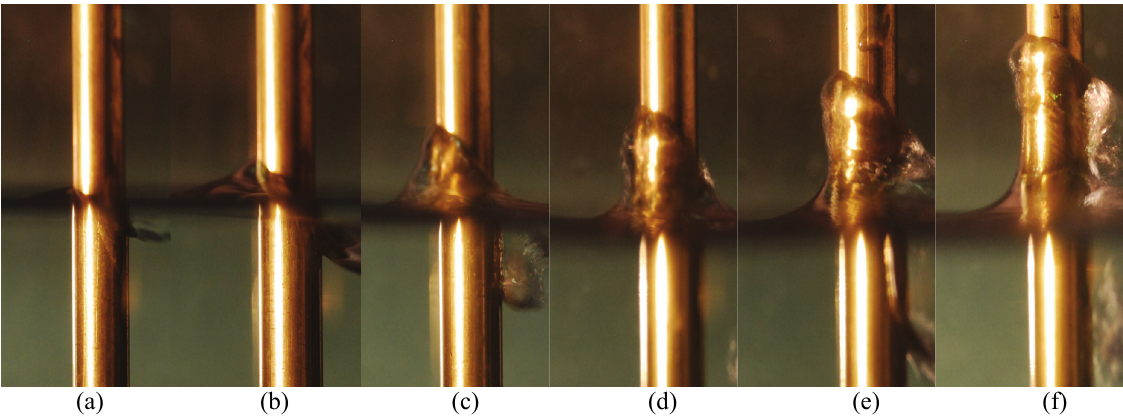
Fig. 4. The aspect of rising of the water surface, submerge depth is 50mm; (a) 0.33m/s, (b) 0.46m/s, (c) 0.59m/s, (d) 0.72m/s, (e) 0.85m/s, (f) 0.98m/s.